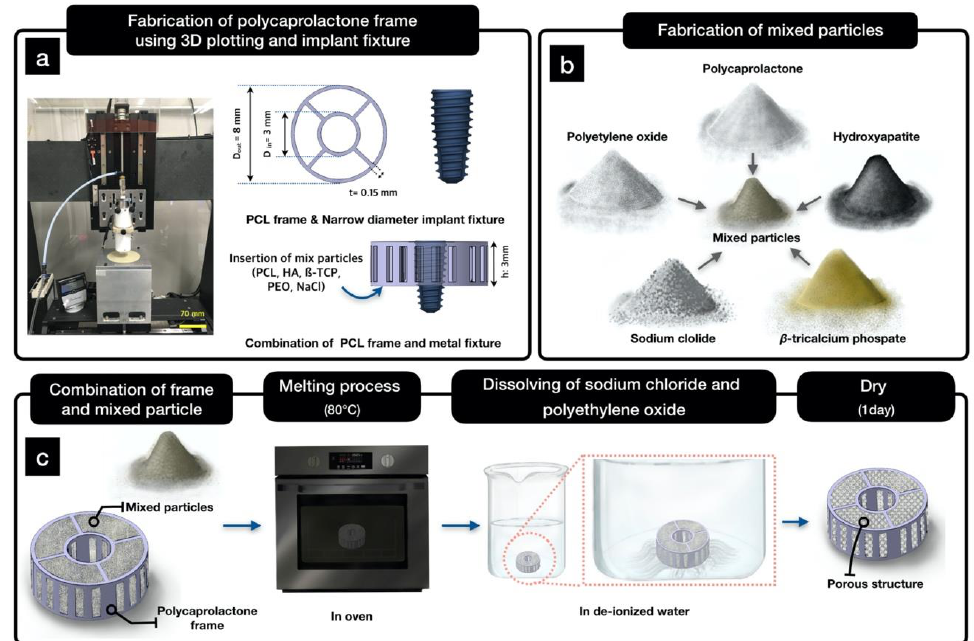
Figure 8. Schematic of the fabrication of a hybrid sca ff old: ( a ) design of the hybrid sca ff old for narrow-diameter implant fixtures; ( b ) preparation of mixed particles; and ( c ) process of the fabrication of the hybrid sca ff